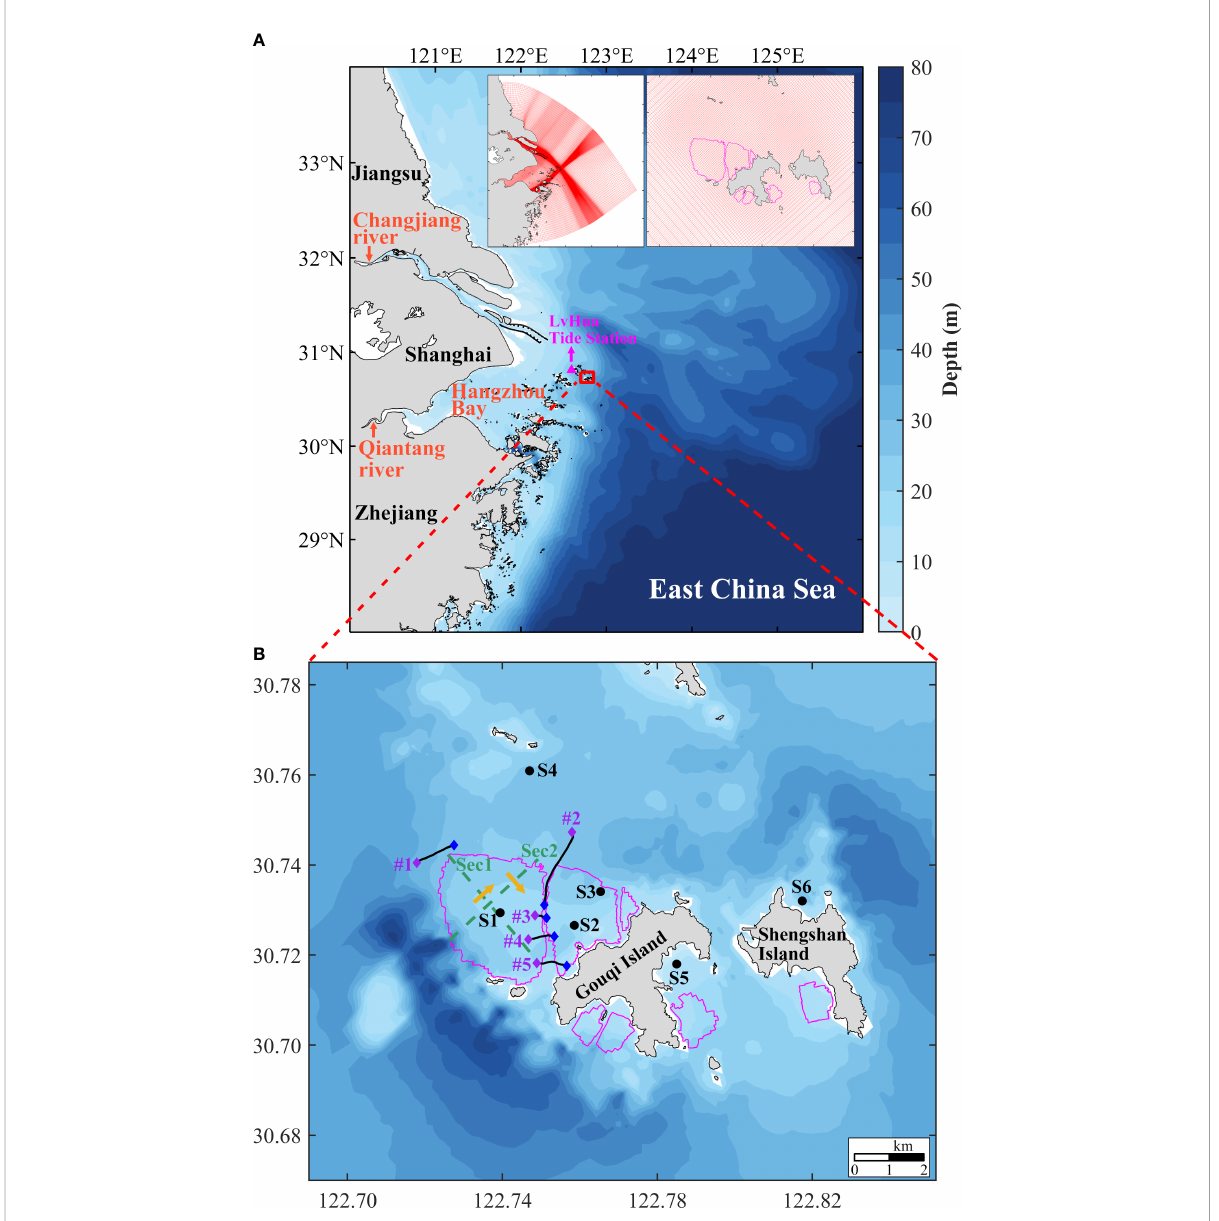
FIGURE 1 Map of the study area, fi eld stations and model grid system. (A) Geographic location of Gouqi Island. The model domain and mesh. Pink triangle indicates the location of LvHua Tide Station (30°49 ′ N,122°36 ′ E). Red rectangle indicates the range of Gouqi Island area. (B) Field observation stations (S1 to S6). The orange arrows show the positive direction of water transport across Sec1 and Sec2 indicated in green dashed lines. The black lines indicate the boat cruise route #1 to #5 for ADCP measurements. The purple and blue diamond are the starting and end point, respectively. The pink lines indicate the borderlines of suspended mussel